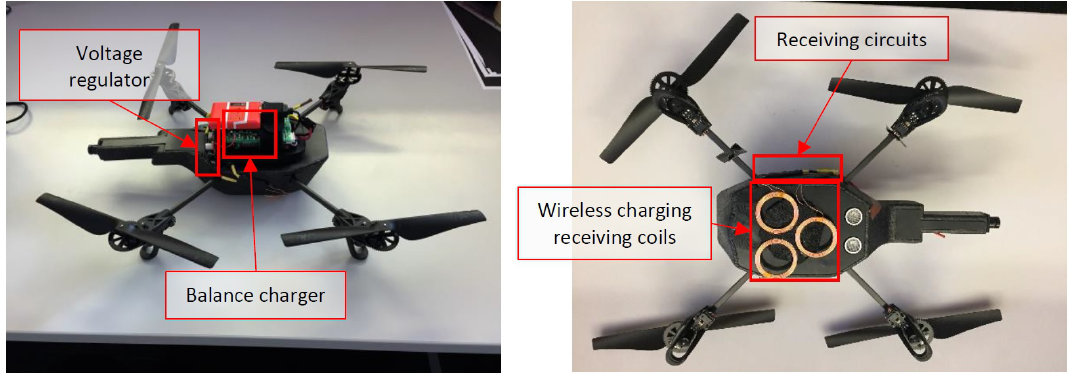
Figure 7. ( Left ) AR.Drone integrated with a voltage regulator and balance charger; ( right ) WPT receiving coils connected in